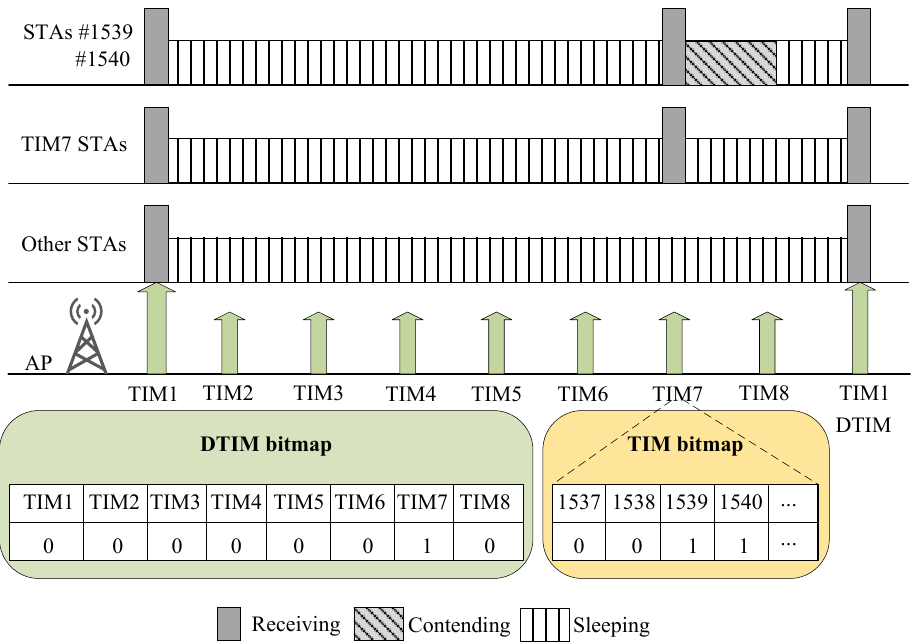
Figure 8. Example of TIM beacon with the non-cross and cross slot boundaries of RAW mechanism